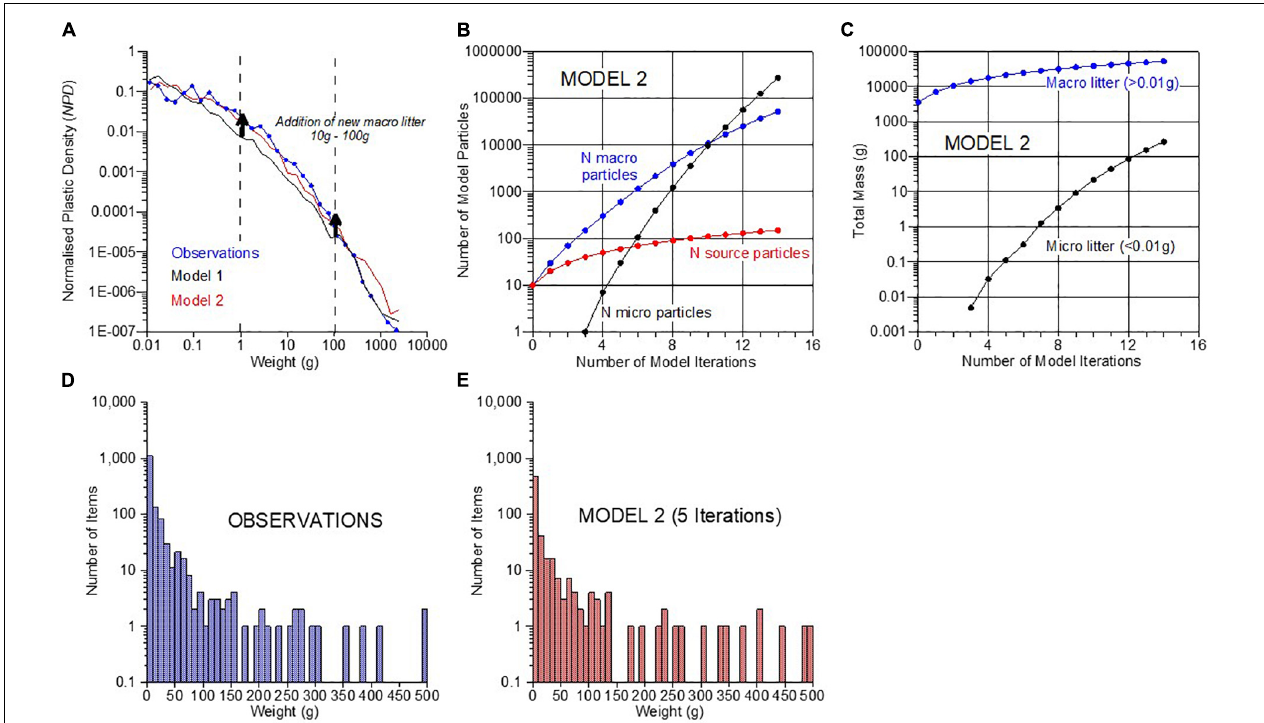
FIGURE 8 | Summary of the final fragmentation model. (A) Normalized Plastic Density ( NPD ): Blue with symbols–observed beach litter; Black–Model 1 (source = mega litter only; 10 iterations); Red–Model 2 (source = macro + mega litter; 5 iterations). (B) Evolution of number of particles in Model 2: Red–total number of new litter items added to model; Blue–total number of macro litter items; Black–total number of micro litter items. (C) Evolution of mass of particles in Model 2: Blue–total mass of macro litter items; Black–total mass of micro litter items. (D,E) Number of litter items (log 10 scale) in 10 g weight bands: (D) Blue–observations; (E) Red–Model 2 after 5